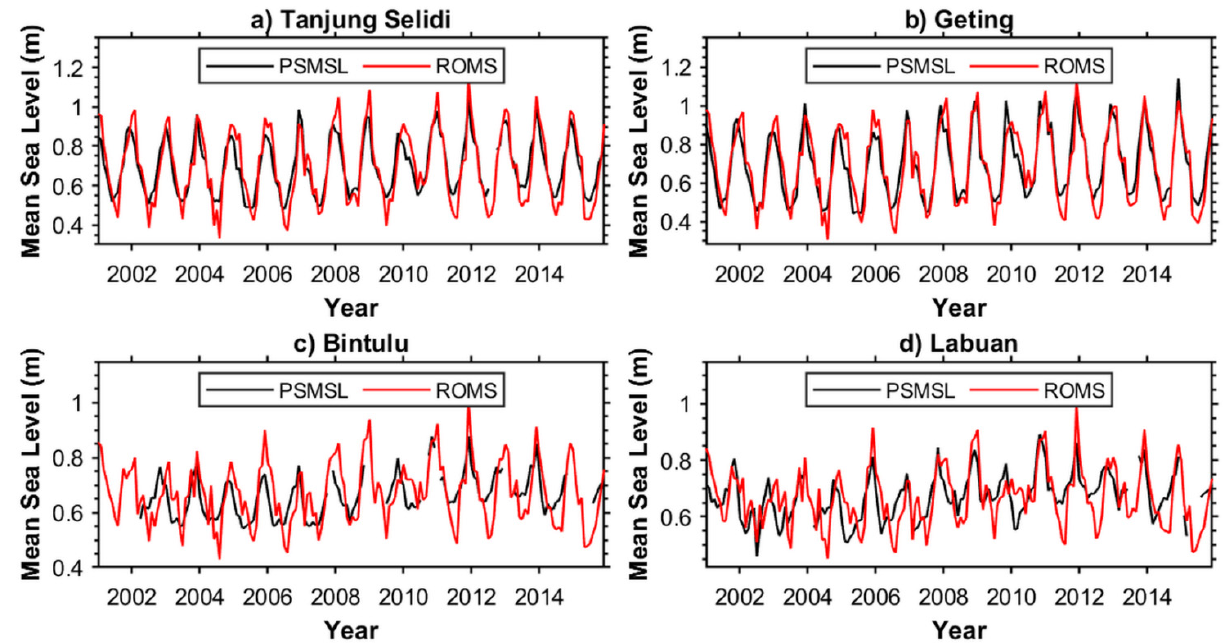
Figure 3. Monthly mean sea levels (unit: m) derived from PSMSL (black lines) and ROMS (red lines) at ( a ) Tanjung Selidi, ( b ) Geting, ( c ) Bintulu, and ( d ) Labuan.